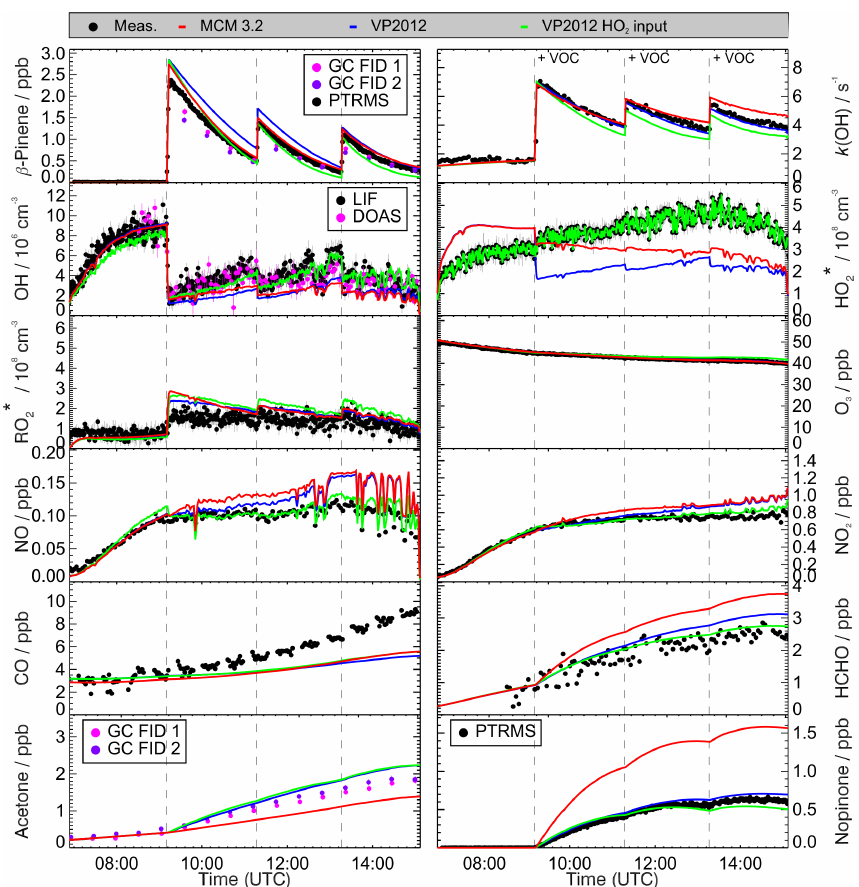
Figure 2. Comparison of the measured and modeled time series of β -pinene, k (OH), OH, HO ∗ nopinone in the β -pinene oxidation experiment from 27 August. Red: MCM 3.2. Blue: modified MCM model by Vereecken and Peeters (2012) with changed product yields. Green: modified MCM model by Vereecken and Peeters (2012) constrained by the measured HO 2